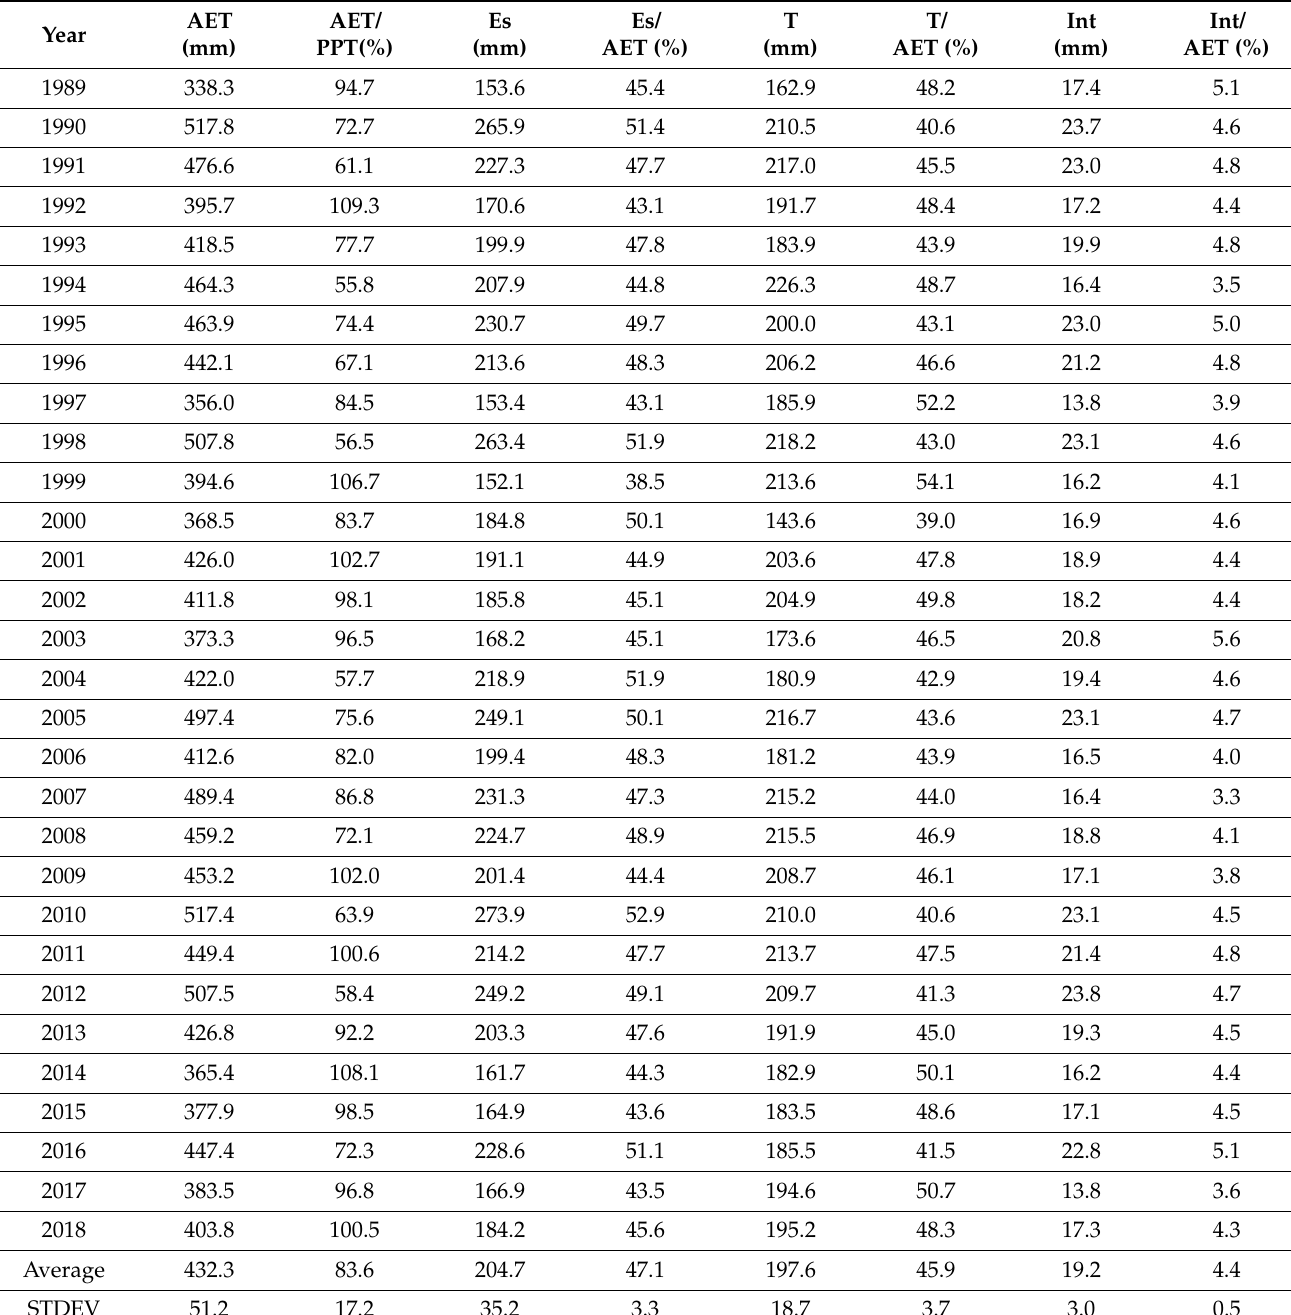
Table 2. Evapotranspiration and its components estimated by the SOILWAT2 model in rainfed maize farmland from 1989 to